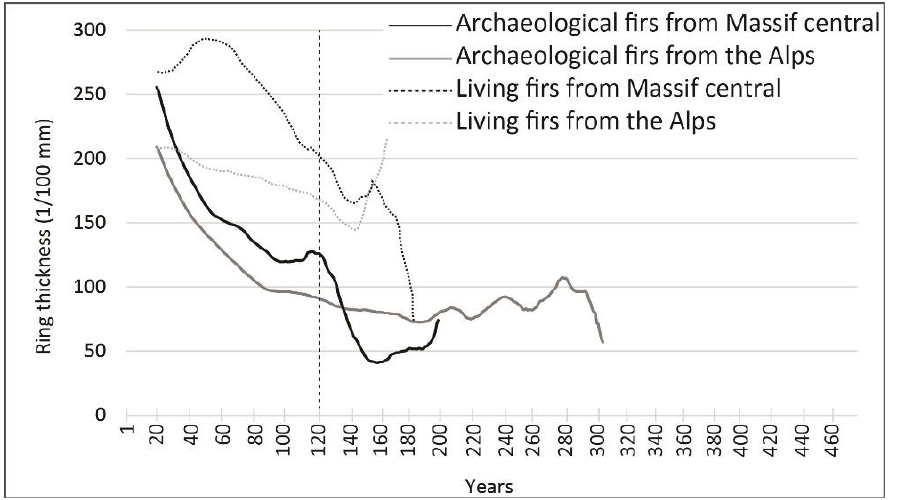
Figure 6. Age trends of Massif Central firs (in black) and Alpine firs (in grey). For comparison, the age trends of the current living trees are shown in dotted curves. After the 120th year (vertical dotted line), the age trends are less representative.